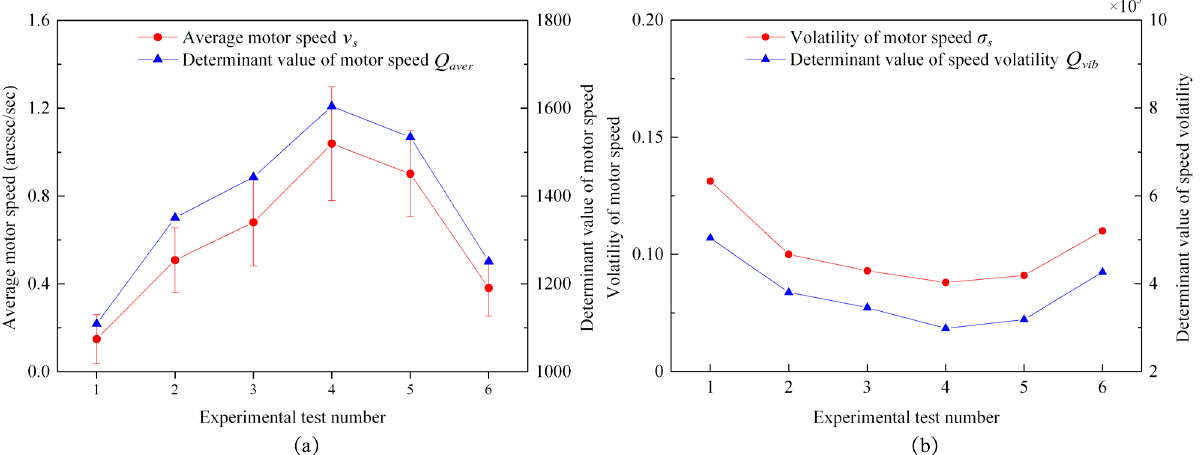
Figure 32. Experimental diagram of the trend in characteristic variables changing with multiple control variables: ( a ) an experimental diagram of the motor’s average speed, v s , and the motor’s average speed determining factor, Q aver ; and ( b ) an experimental diagram of the tendency of the speed volatility, σ s , and the speed volatility determinant, Q vib